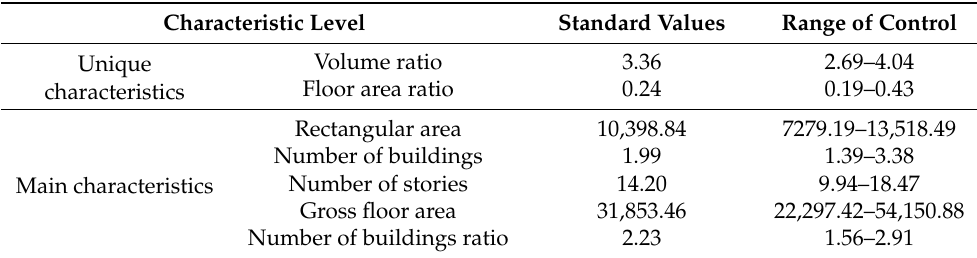
Table 6. SCUT Wushan campus block form renewal control indicators.